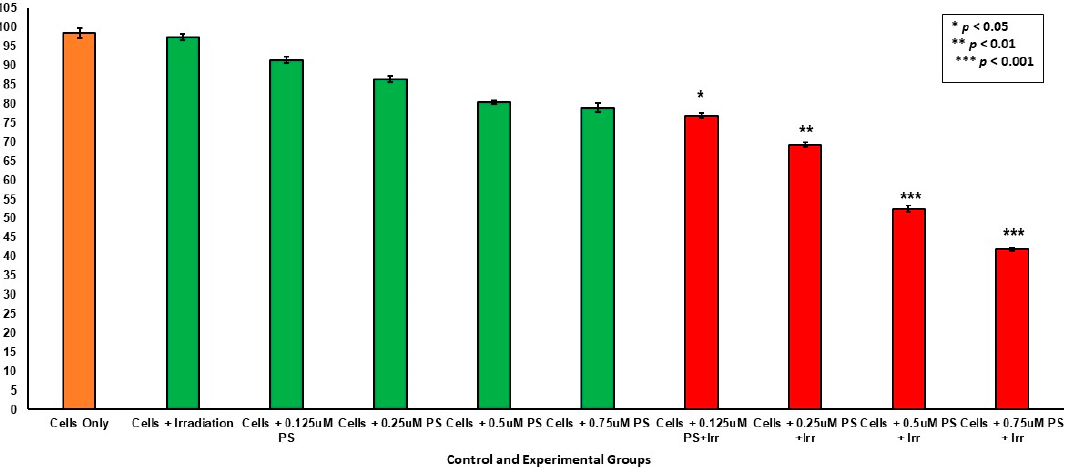
Figure 6. Caco-2 trypan blue cell exclusion viability analysis results of AlClPcTS41 (PS) treated cells, (* p < 0.05, ** p < 0.01, *** p < 0.001 ) shows statistical significance compared to cells only (control).